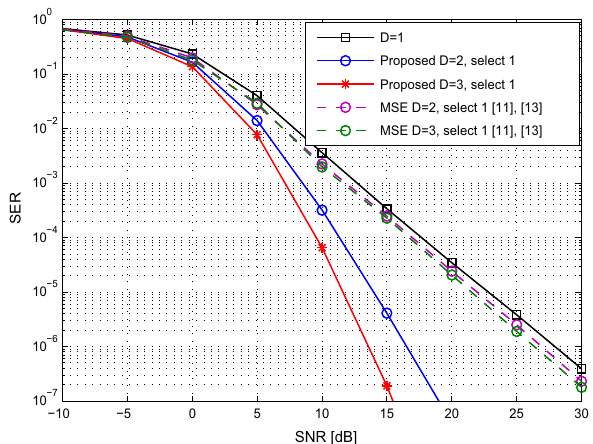
Fig. 4 SER performance of the simple STBC-CQ-PNC system with relay selection